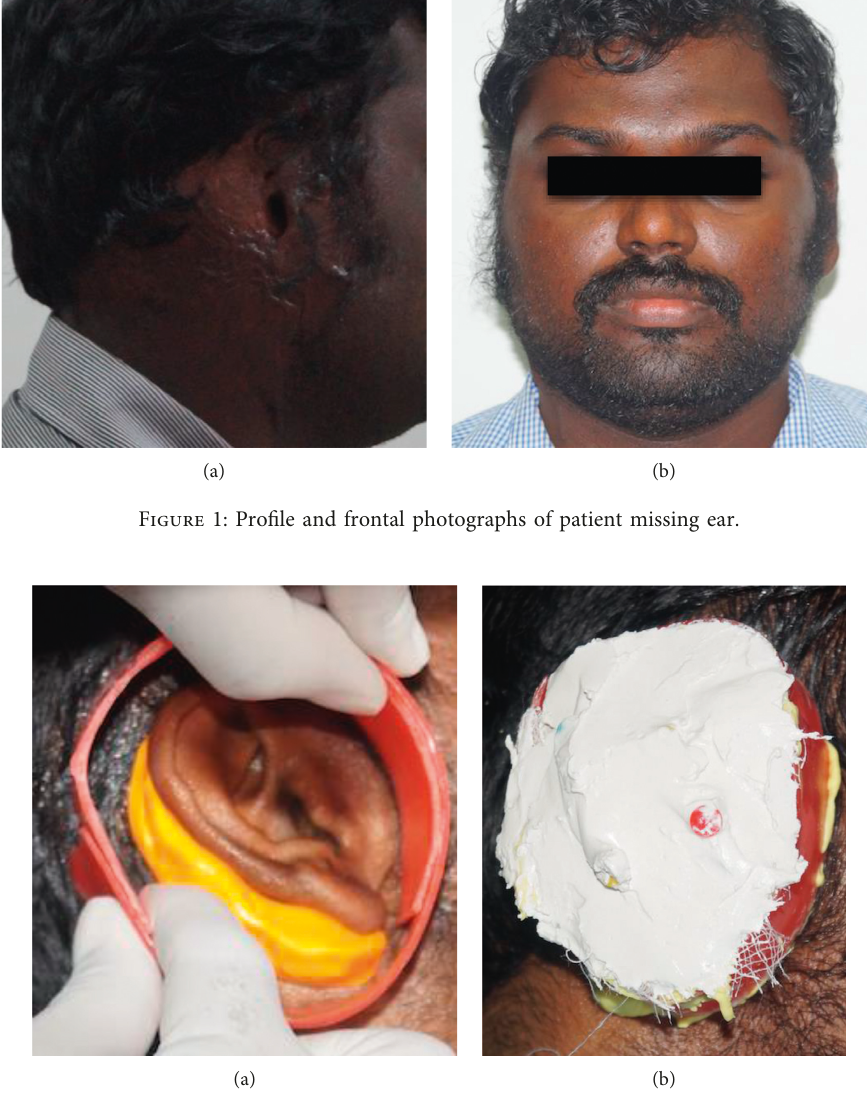
Figure 2: Impression of donor ear using irreversible